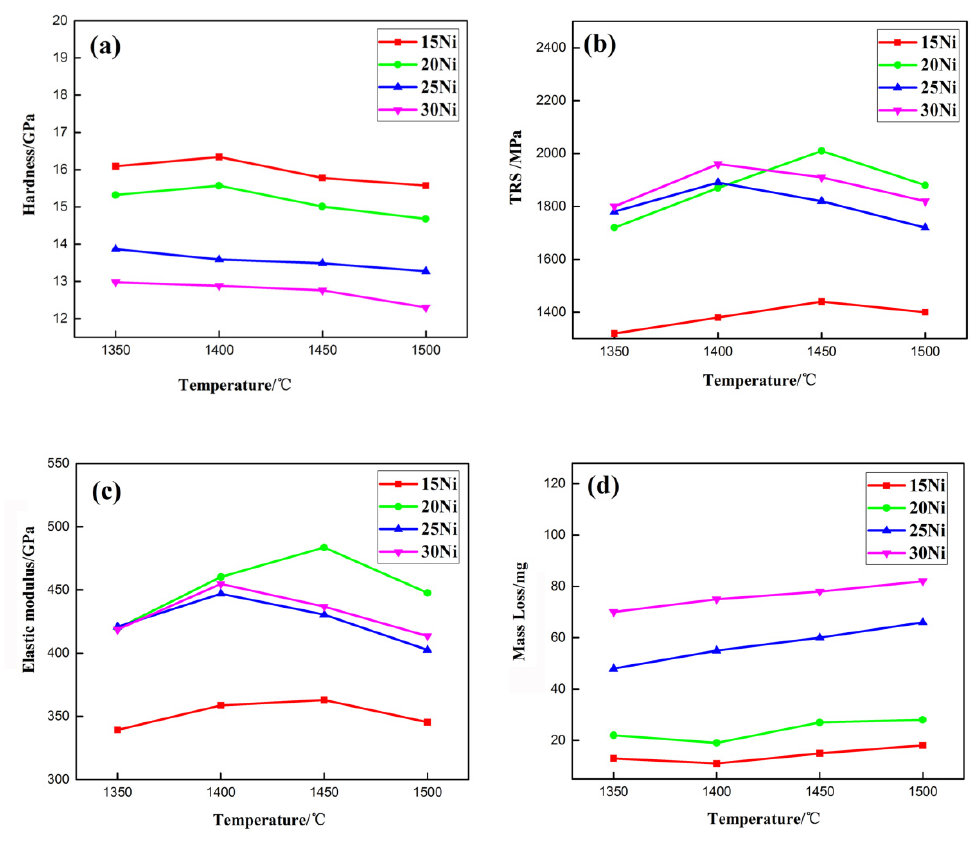
Figure 9. Effect of metal binder phase content and sintering temperature on Ti(C,N)-based cermets: ( a ) Vickers hardness; ( b ) TRS; ( c ) elastic modulus; ( d ) wear resistance.